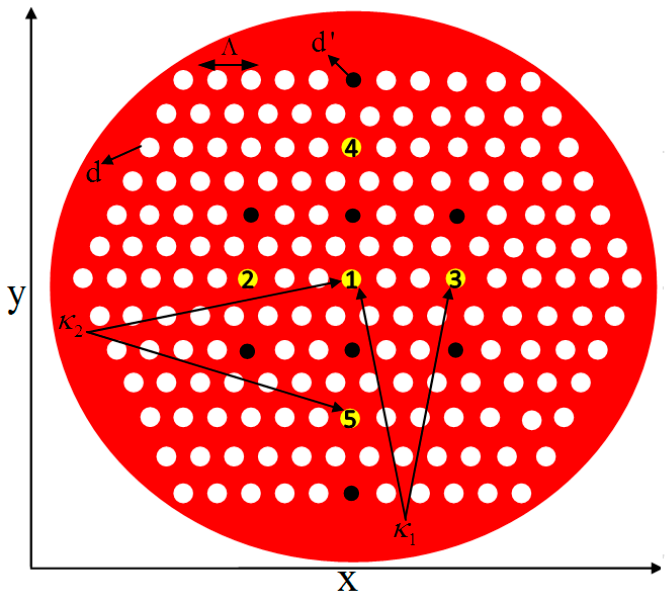
Figure 1. Schematic sketch of the 4 × 1 power combiner design at the x–y plane.